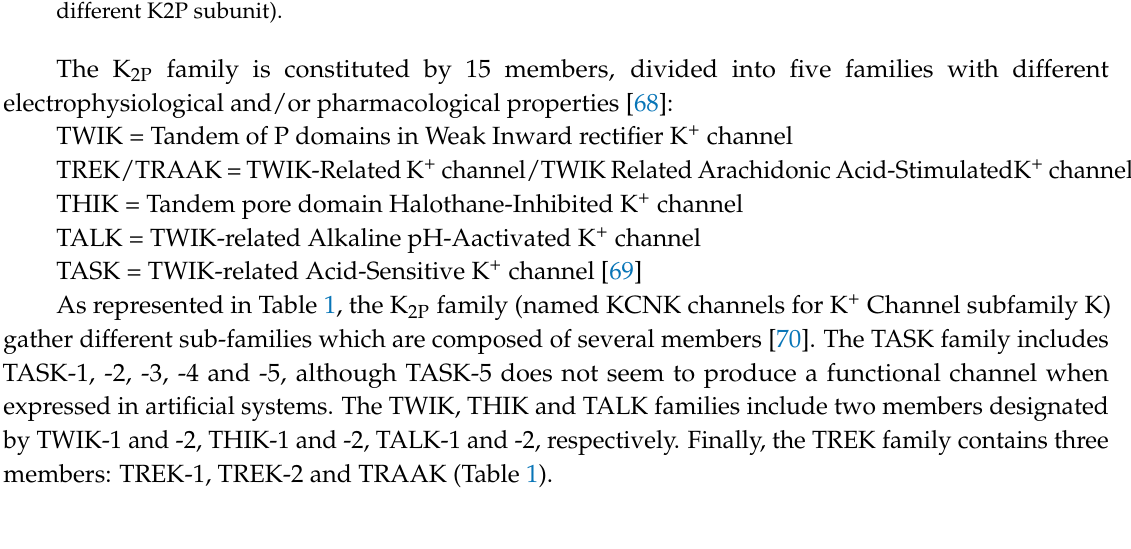
Table 1. Nomenclature of each K 2P channel subunit.